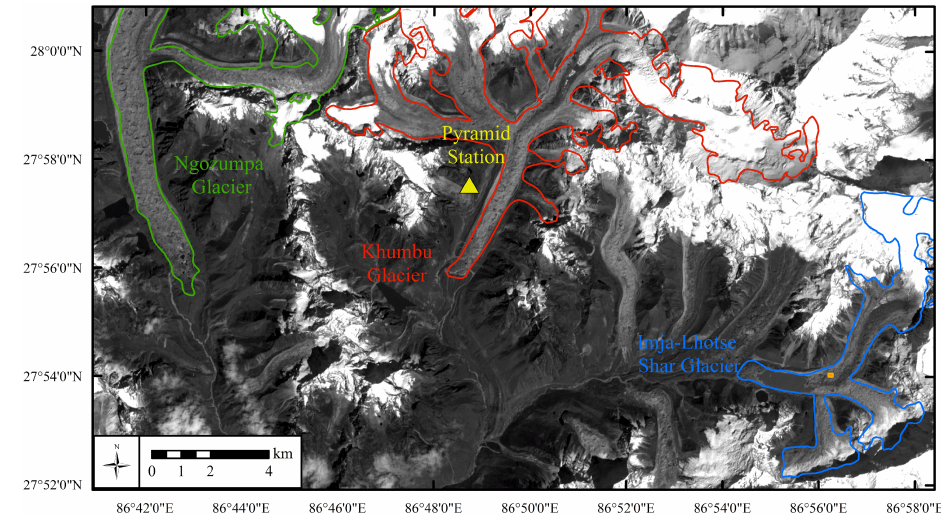
Figure 1. Panchromatic band from Landsat7 on 4 October 2002 showing Imja Lake, the focus area on Imja–Lhotse Shar Glacier, and Pyramid Station amongst debris-covered glaciers in the Everest region.